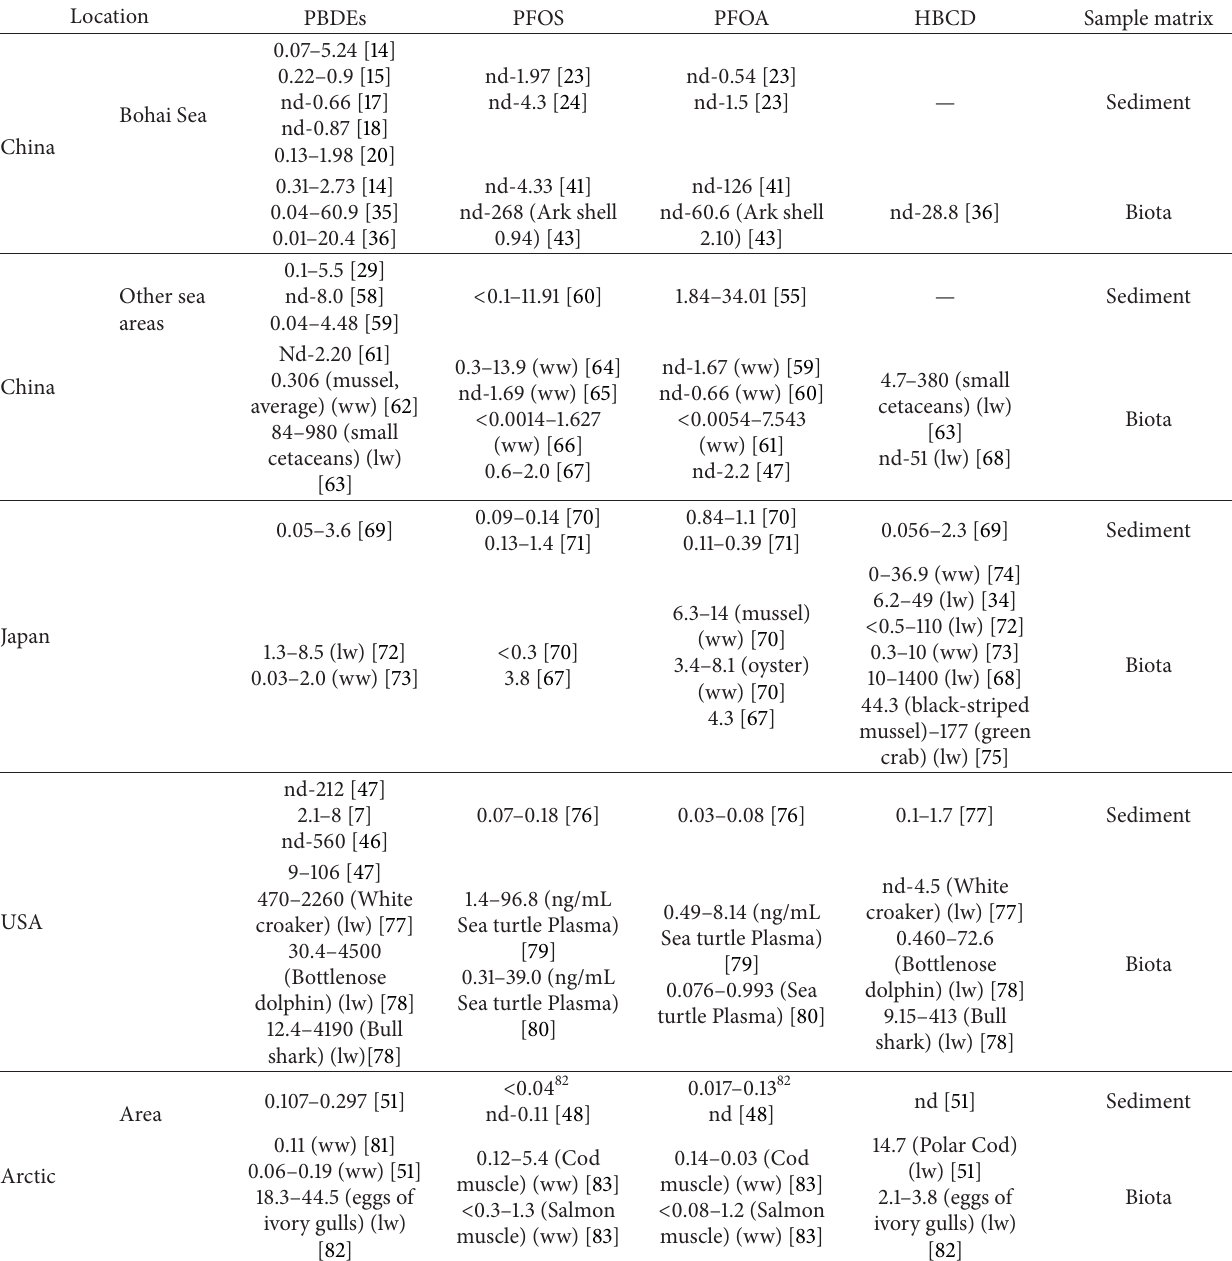
Table 1: Comparison of emerging organic pollutants in different matrix among Bohai Sea and other